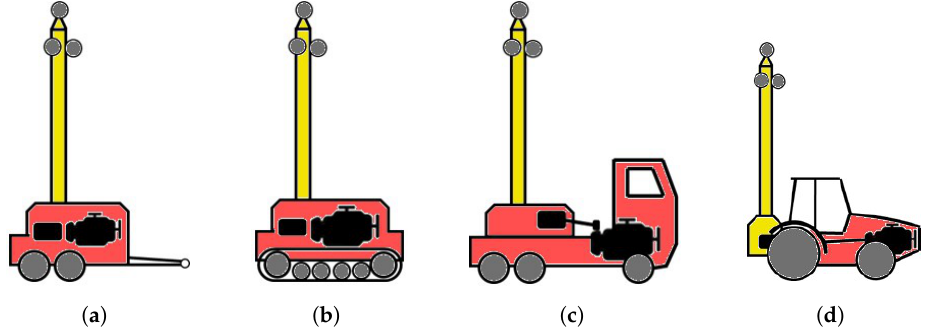
Figure 3. Common types of tower yarder systems. ( a ) Trailer mounted with dedicated engine. ( b ) Self-propelled tracked vehicle. ( c ) Mounted on and propelled by a truck. ( d ) Mounted on and propelled by a